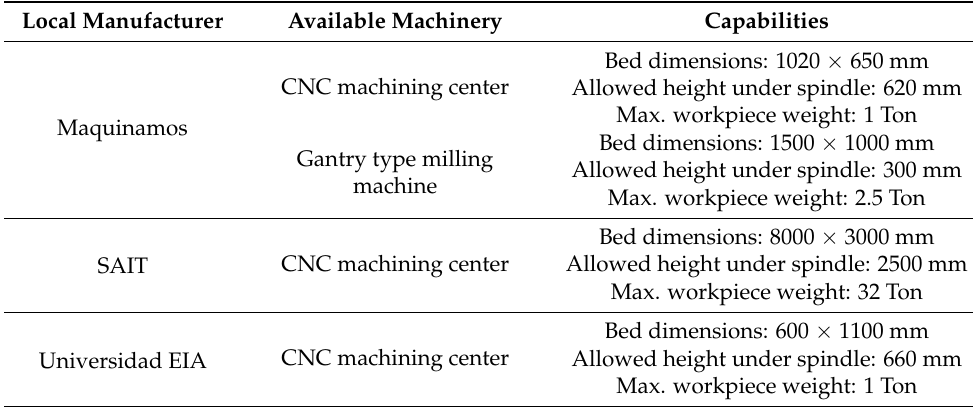
Table 2. Local available machinery